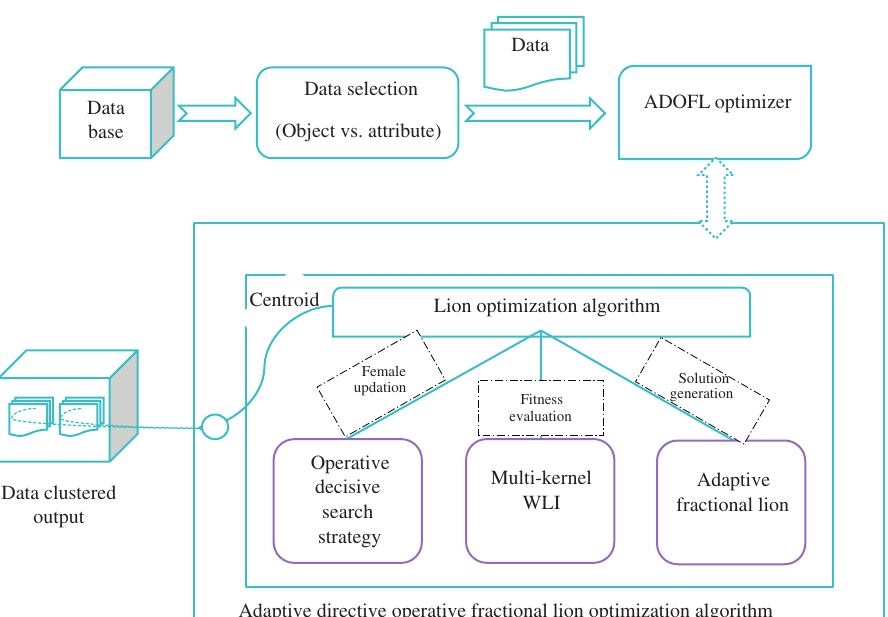
Figure 1: Proposed ADOFL Optimization